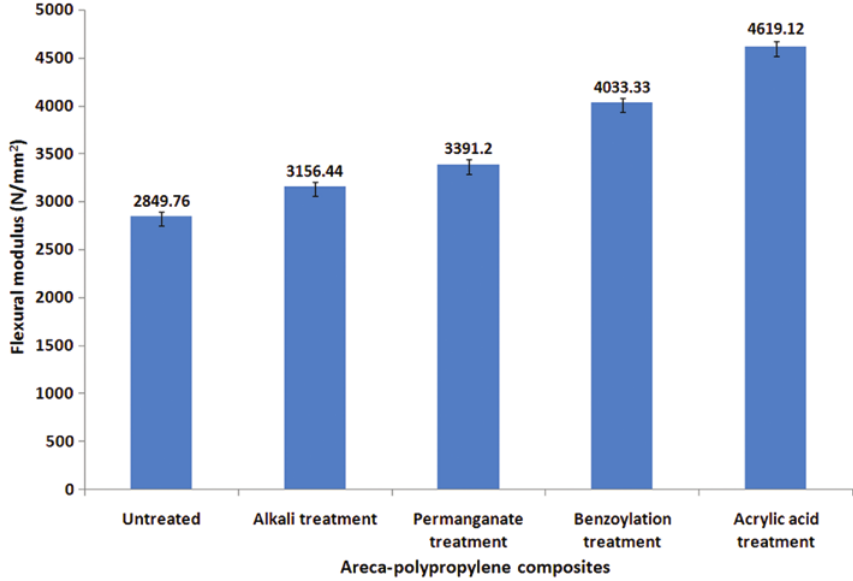
Figure 4: Flexural modulus of areca-polypropylene composites with 60% fiber